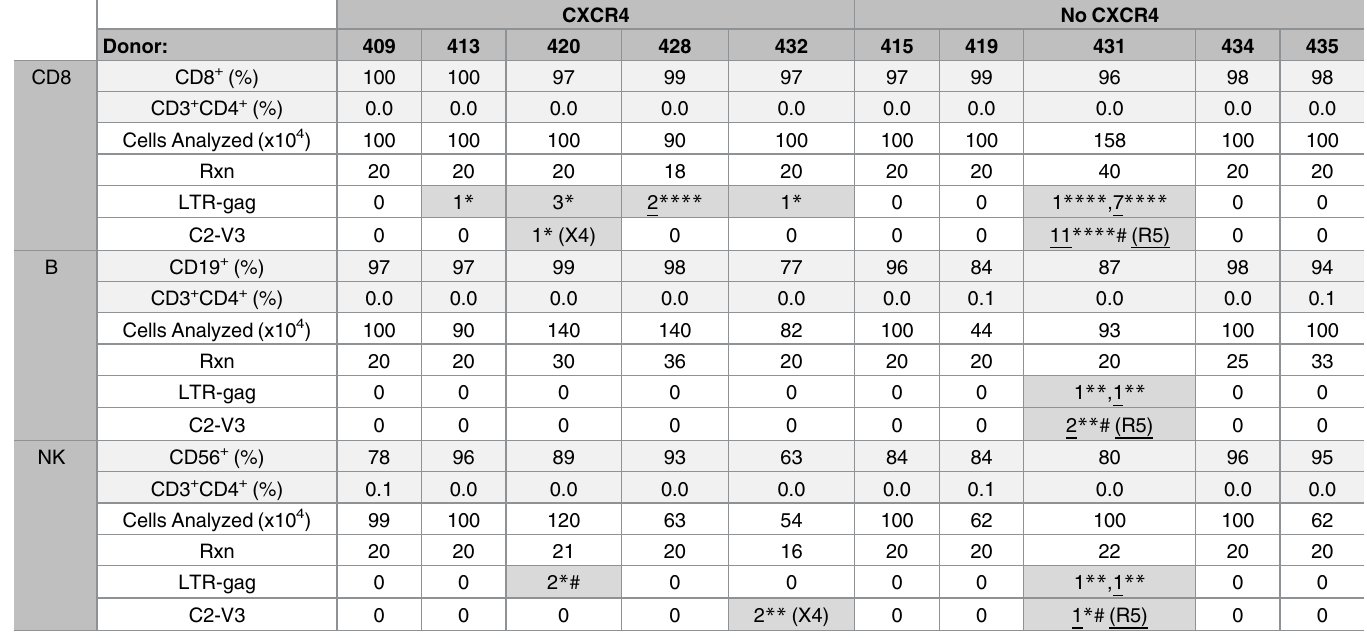
Table 5. HIV isolation from CD4-negative lineages from a subset of ten donors.